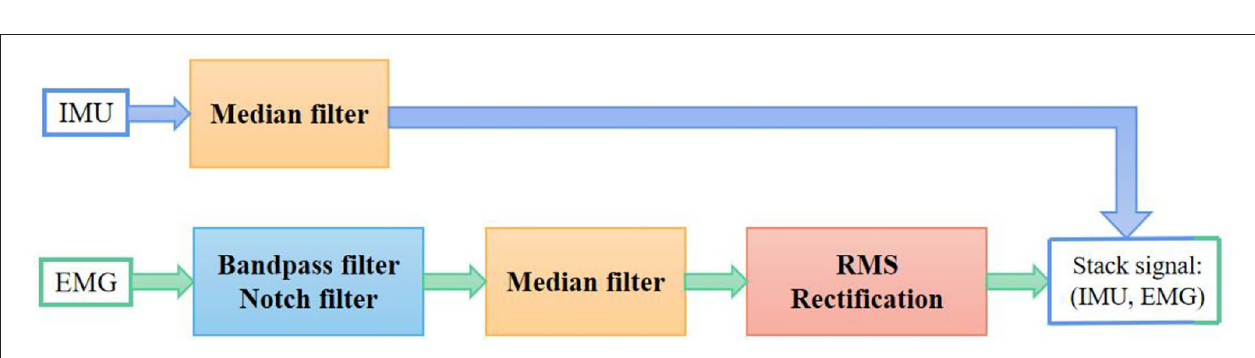
FIGURE 2 | Signal preprocessing